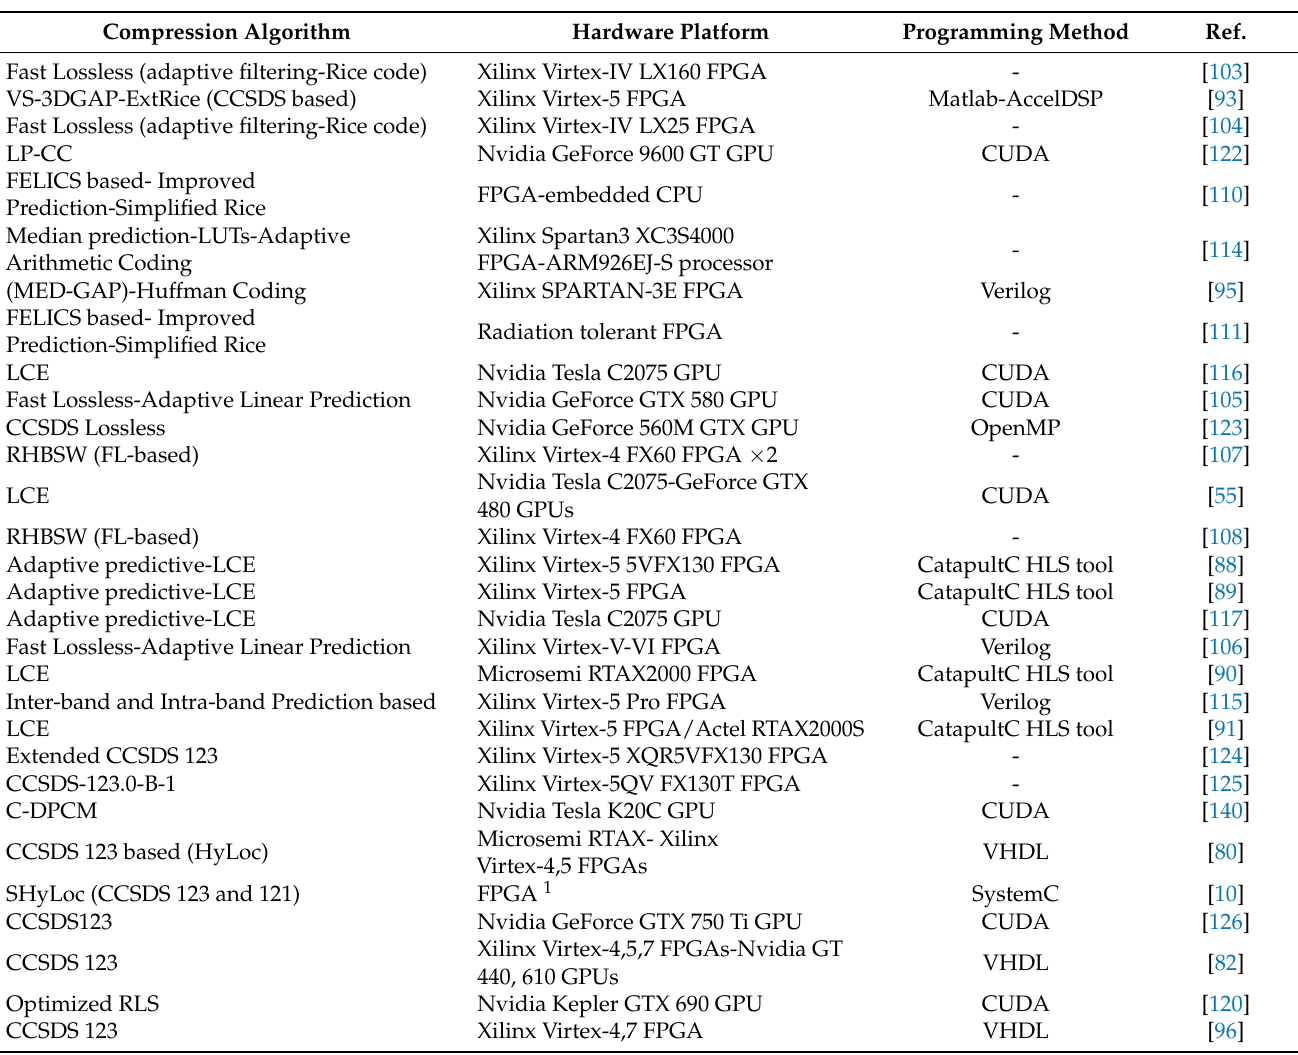
Table 3. List of studies on prediction-based compression systems of hyperspectral images and their hardware